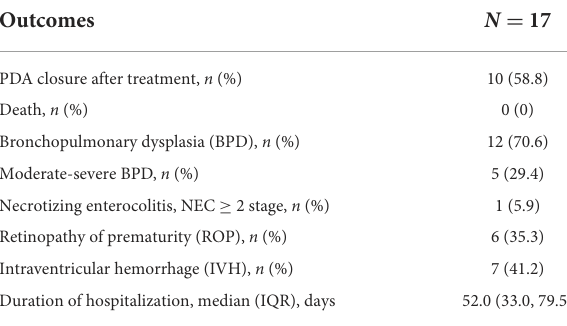
TABLE 3 Neonatal outcomes of 17